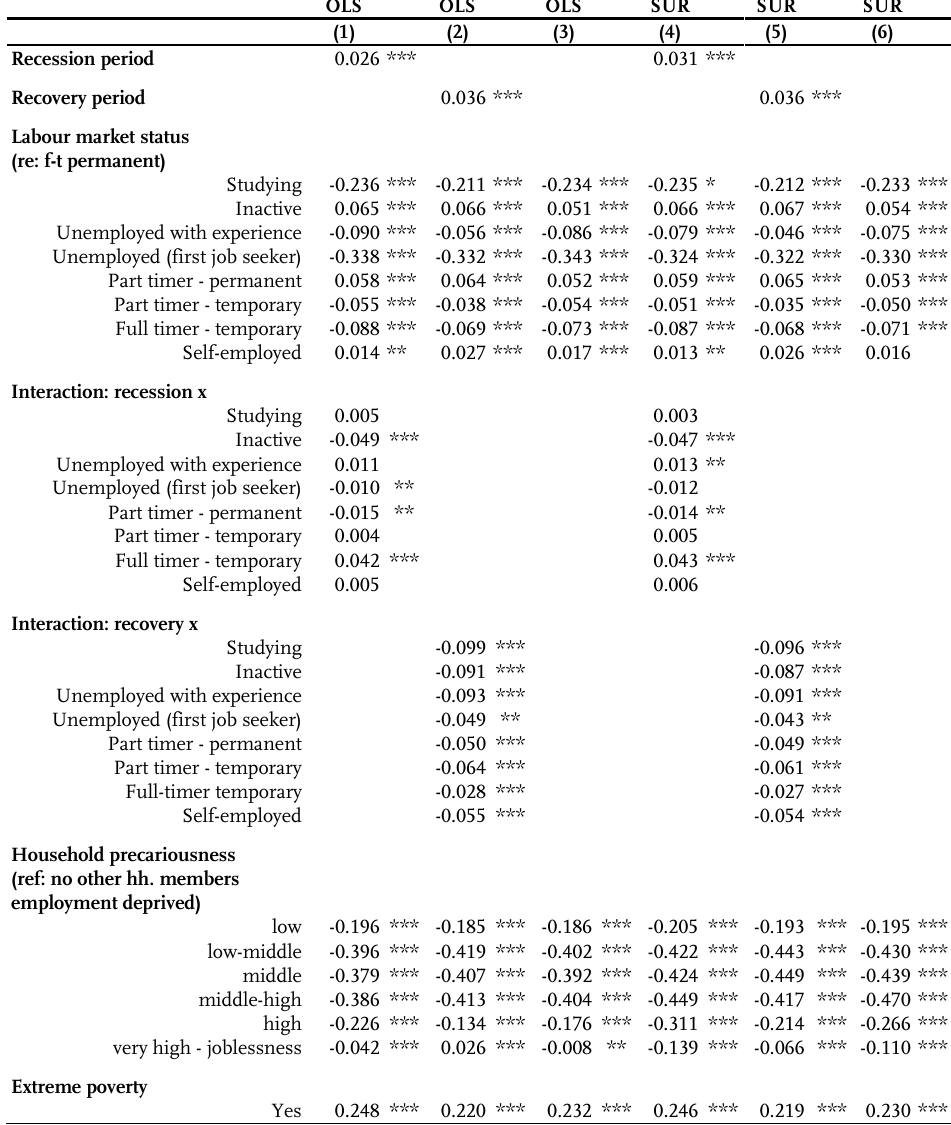
Table 3a: OLS and Seemingly Unrelated Regression results on emancipation for females between 26-34 years of age (1=cohabiting),